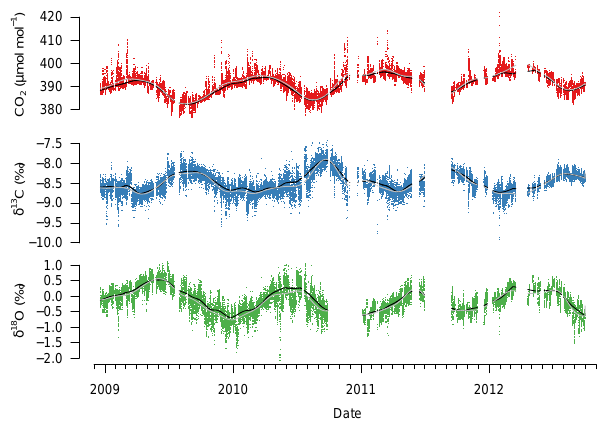
Fig. 6. Overview of the data record from December 2008 to Septem- ber 2012. Hourly averaged data of CO 2 (red), δ 13 C (blue) and δ 18 O (green) as well as fitted background curves (black: local regression, gray: smooth curve fit, see text for explanation) are